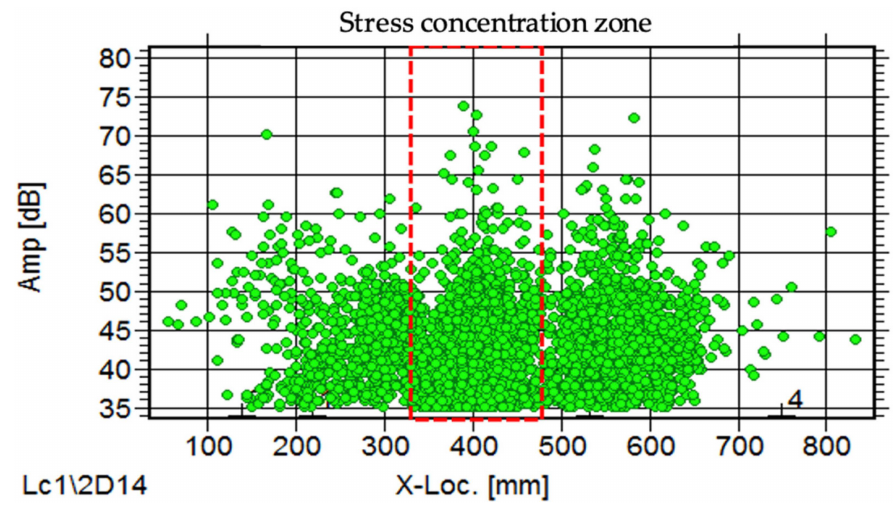
Figure 18. Acoustic emission amplitude along the span of the